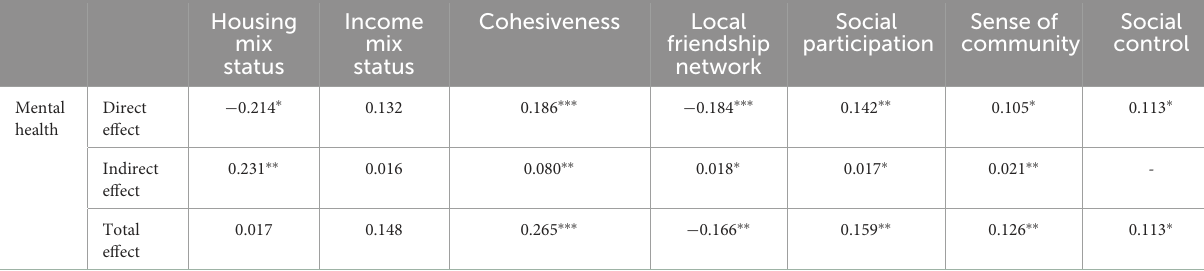
TABLE 3 Total, direct, and indirect effects of independent variables on mental health wellbeing (Std estimate, N =